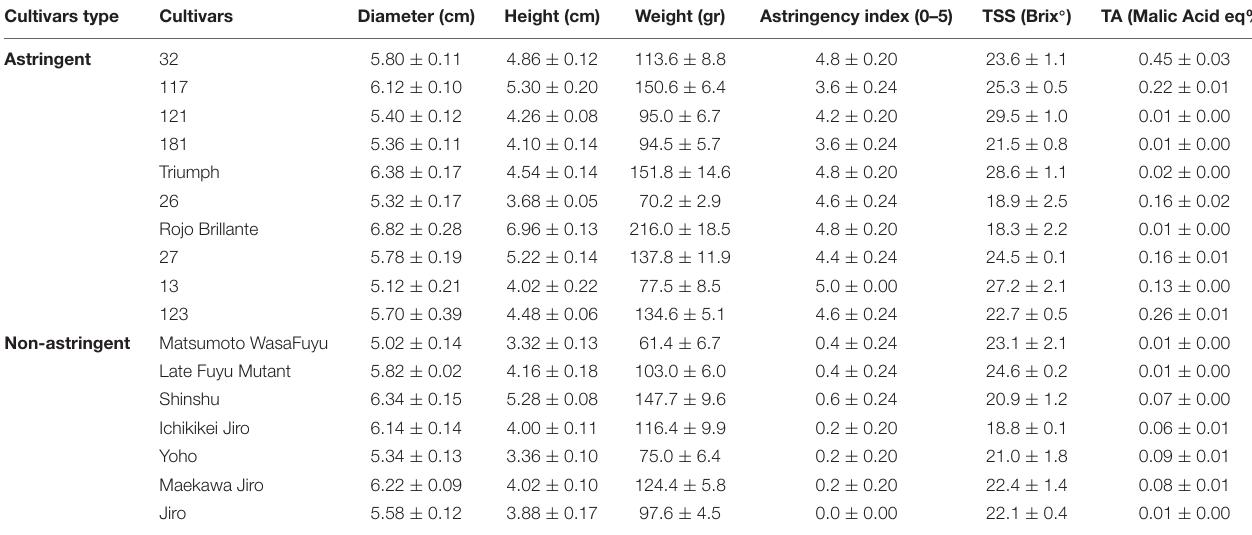
The results show the average of 5 representing fruits of each cultivar at harvest; ± SE. The data are of fruit from 2017.